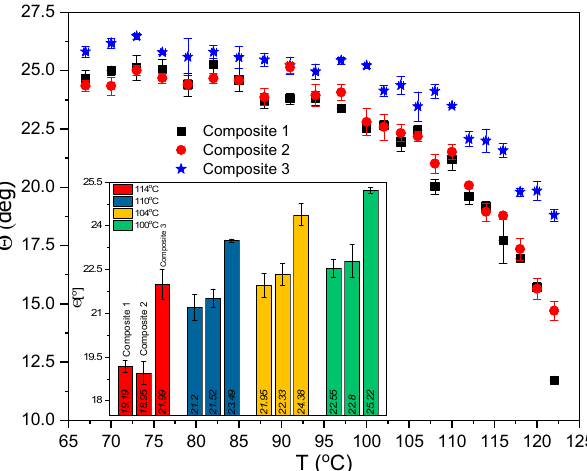
Figure 12. Temperature dependence of the tilt angle for Composites 1–3, f = 50 Hz, U = 120 V within the SmC* A phase. Inset shows the tilt angle for the chosen temperatures.